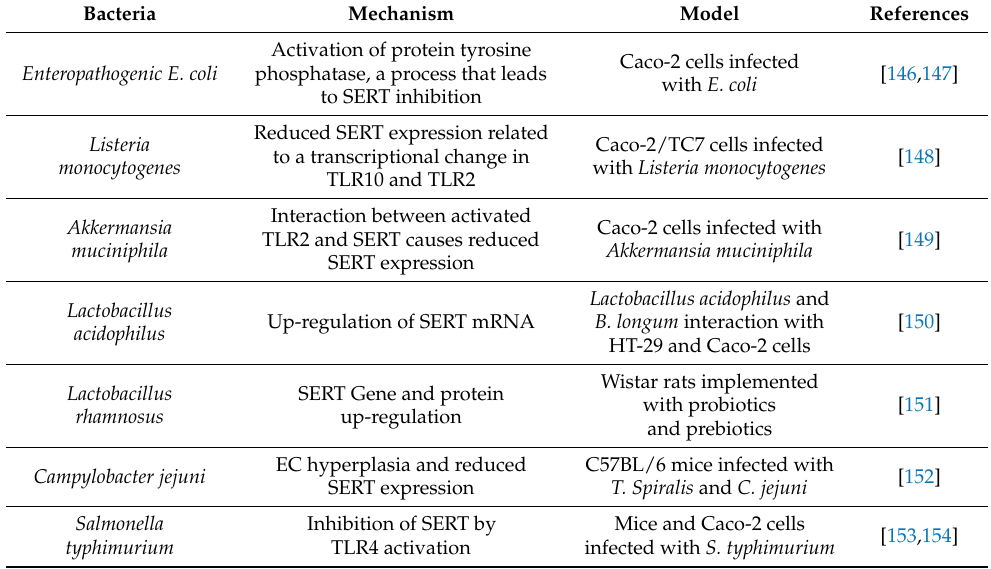
Table 3. Relationships between bacteria and SERT